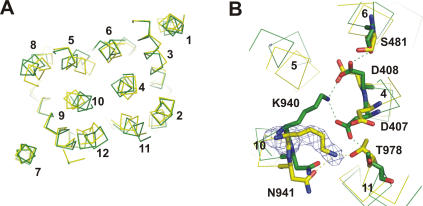
Conformational Changes in the TM Region of AcrB(A) Wire model of the superpositioned TM domains of subunit A and subunit C viewed from the periplasmic side. Subunit B is omitted since it displays a similar conformation as subunit A. The individual helices are labeled.(B) Detailed interactions of the amino acid residues in the putative proton-translocation site viewed in the same orientation as in (A). Residues involved in the hydrogen-bonded network (dashed lines) are labeled. The |Fo-Fc| omit electron density map (blue mesh) of Lys940 in subunit C is contoured at 3.5 σ.